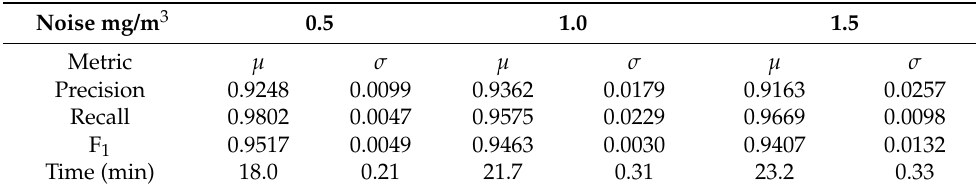
Figure 7. The red zone estimation of the Narrow Passage pollution scenario performed using the BREEZE approach with a Gaussian noise of 0.5 mg/m 3 . The grey cells are ground truth, the red cells are True-Positive, the green cells are False-Positive, and the blue cells are obstacles. Table 2. The data gathered in the Narrow Passage scenario for three different noise levels (0.5, 1.0, and 1.5 mg/m 3